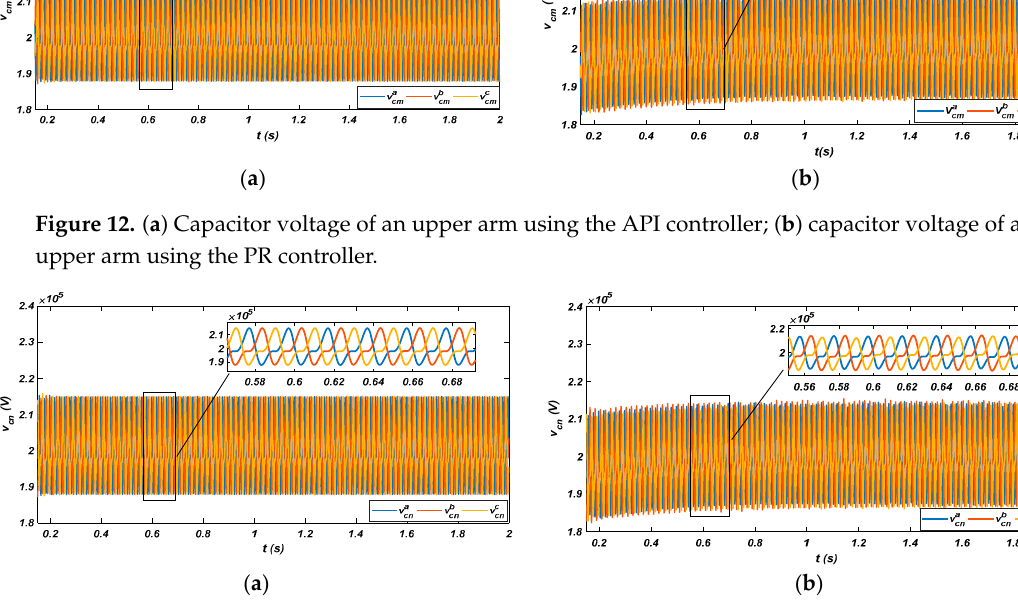
Figure 13. ( a ) Capacitor voltage of a lower arm using the API controller; ( b ) capacitor voltage of a lower arm using the PR controller.